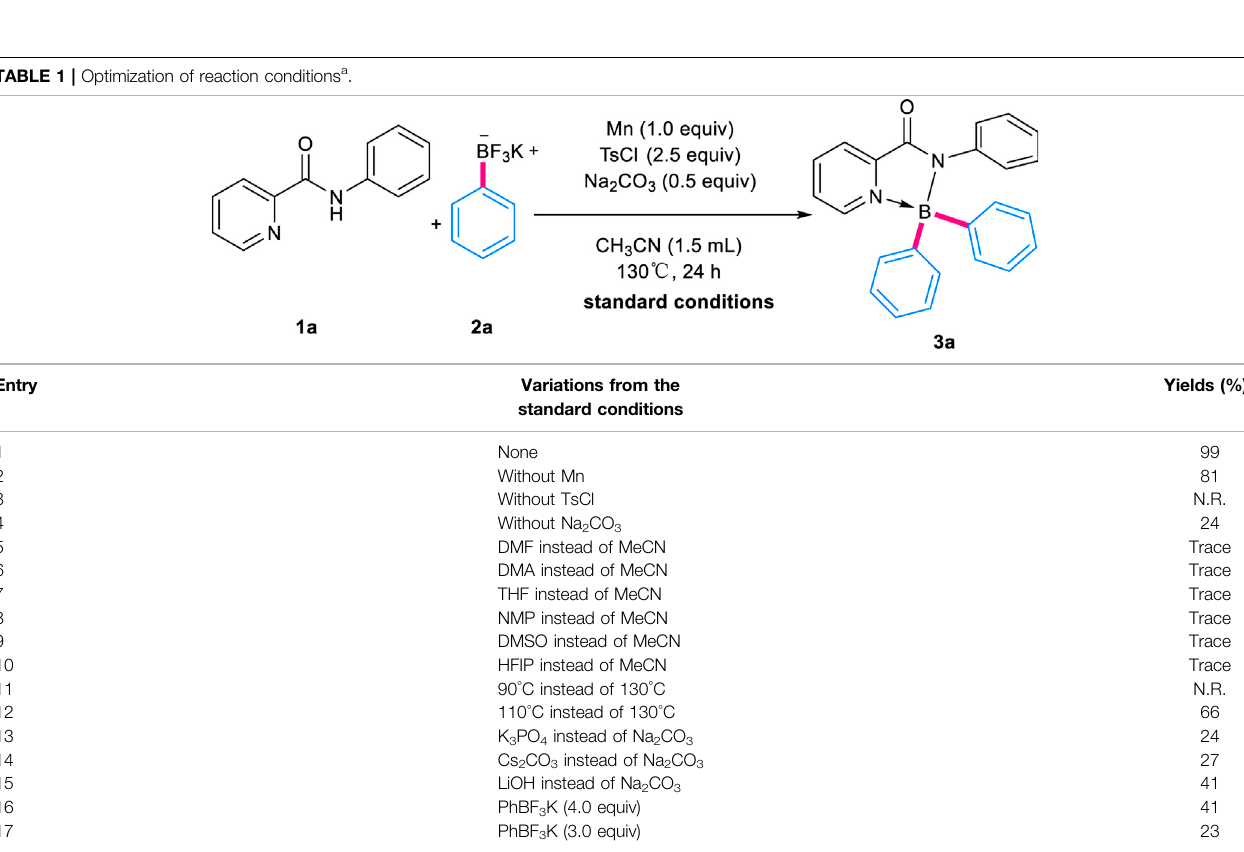
TABLE 1 | Optimization of reaction conditions a